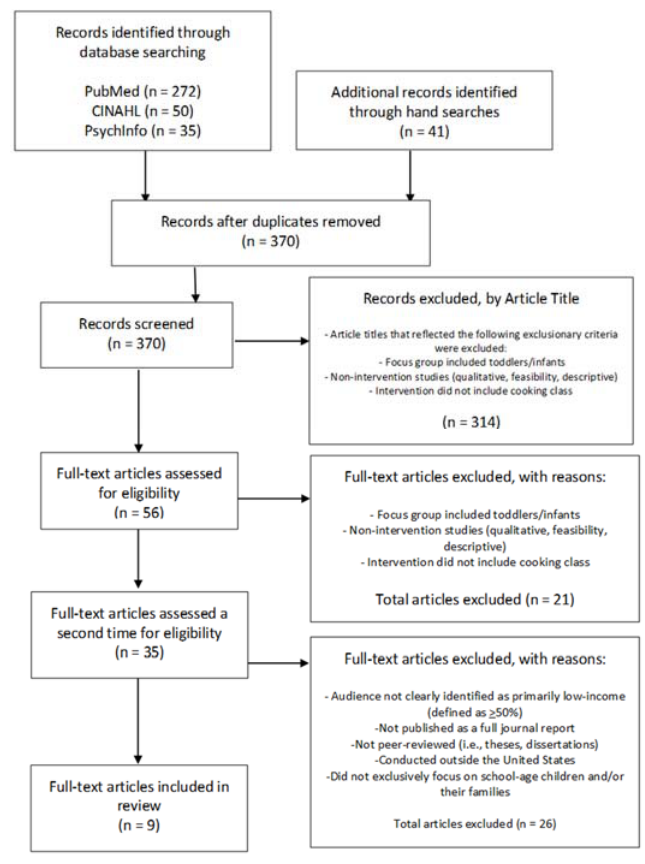
Figure 1. Consort Figure 1. Consort Diagram.